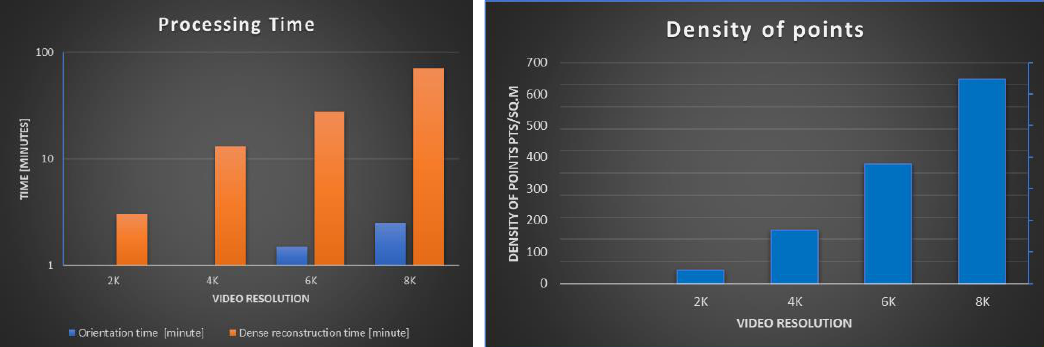
Figure 7. First experiment results: ( left ) the relation between the video frame resolutions and the consumed time for processing at a logarithmic scale; ( right ) the relation between the video resolution and the point densities.